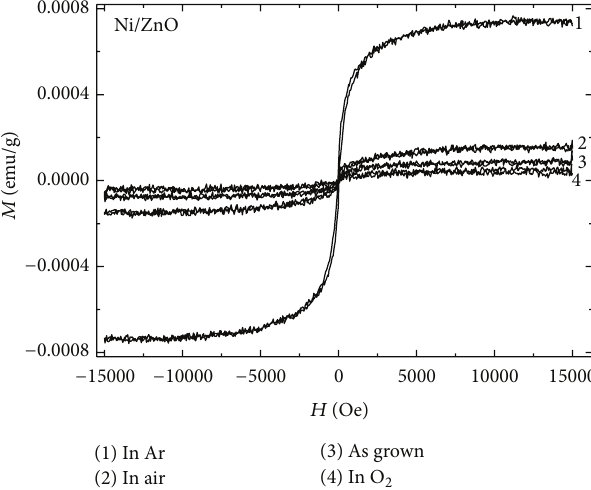
Figure 5: Magnetic hysteresis of Ni doped ZnO samples as grown and postannealed in different atmospheres (O 2 , air, and